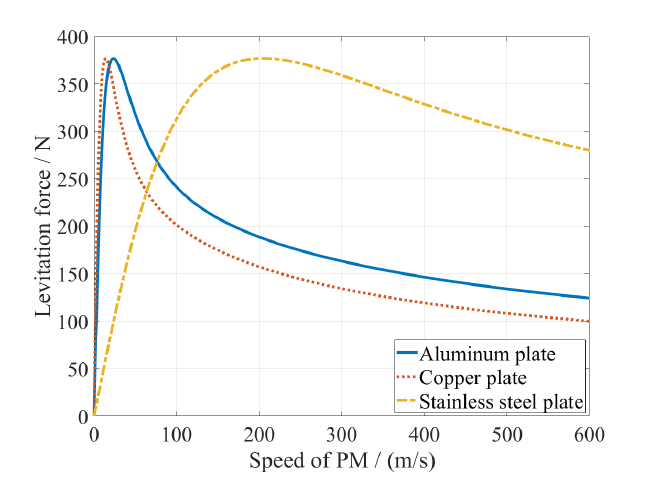
Figure 13. Variations in levitation force due to the speed with different plate materials.